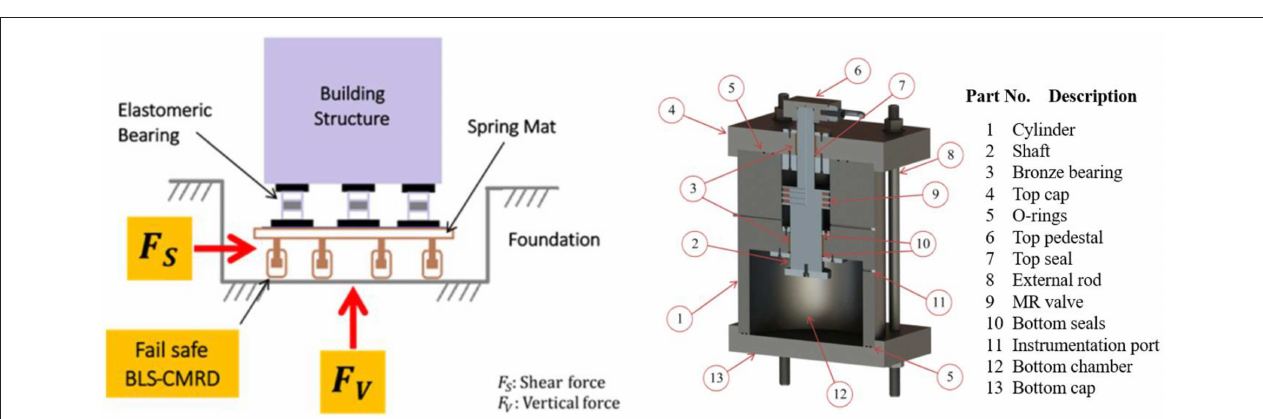
FIGURE 4 | 3D view and detailed diagram of the Negative Stiffness Devices (Cimellaro et al., 2018).